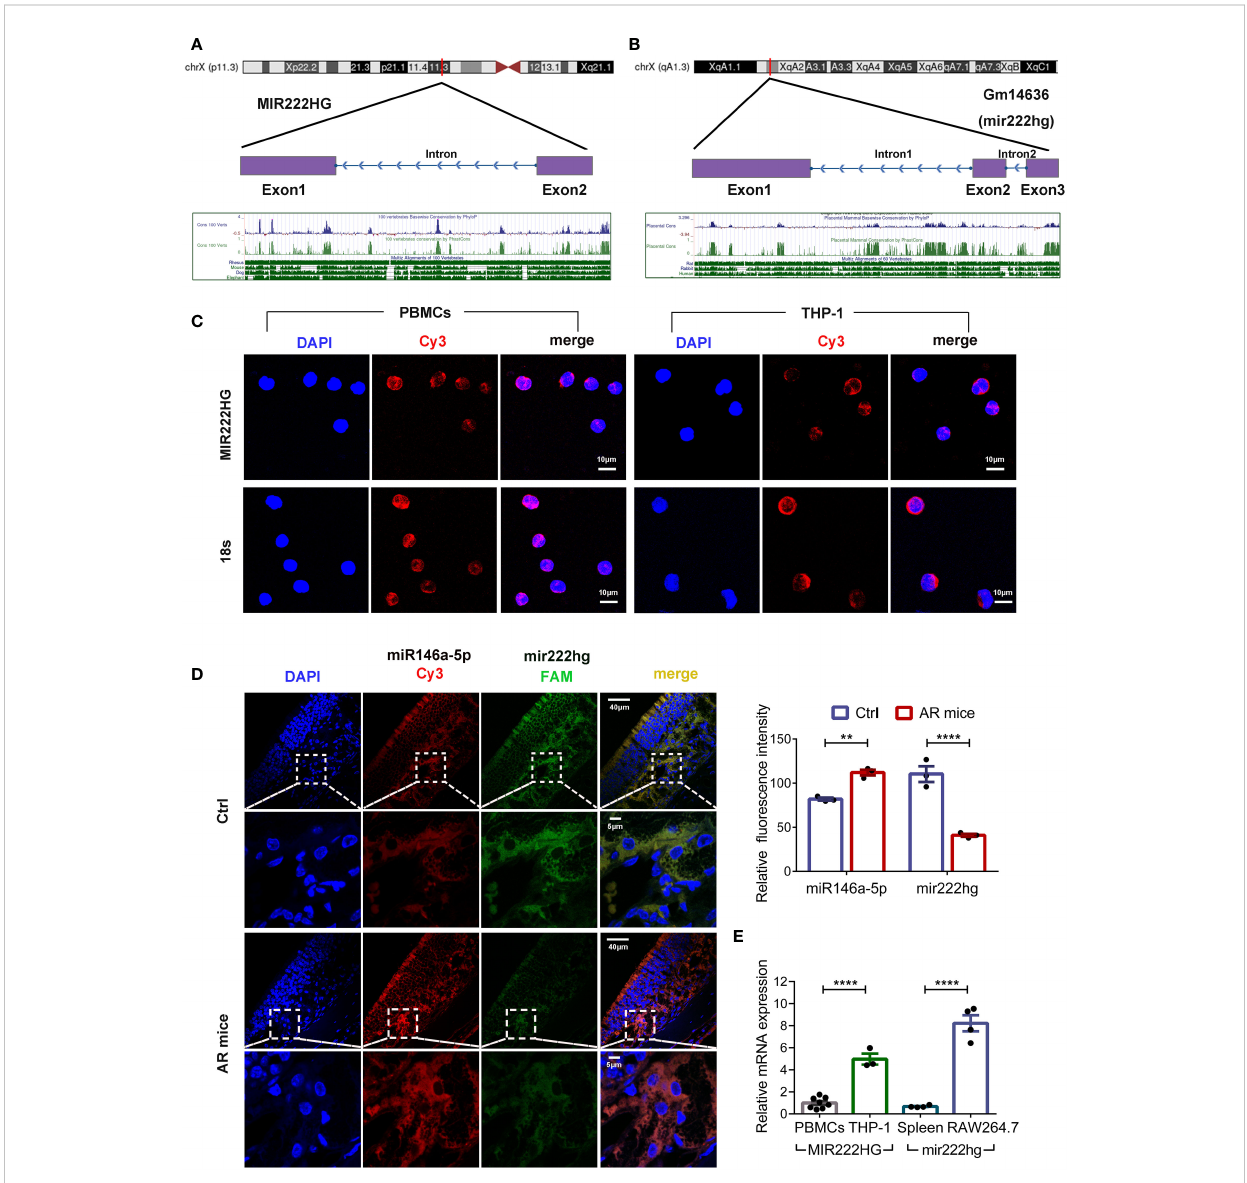
FIGURE 3 Conservation analysis and subcellular localization of MIR222HG/mir222hg (A) MIR222HG is mapped to the human chromosome X:45,745,211- 45,770,274 with a high degree of conservation in its sequence. (B) Gm14636(mir222hg) is located on murine chromosome X:19,023,220-19,033,471 with a high degree of conservation in sequence. (C) Representative images of RNA-Fluorescence in Situ Hybridization (RNA-FISH) assay showing subcellular localization of MIR222HG in PBMCs and THP-1 cells (MIR222HG-Cy3-red; nucleus-DAPI-blue). 18s was used as the positive control. Scale bars, 10 m m. (D) Representative images (left) and quanti fi cation analysis (right) of RNA-FISH assay showing subcellular localization and expression of mir222hg and miR146a-5p in nasal mucosa tissues (miR146a-5p-Cy3-red; mir222hg-FAM-green; nucleus-DAPI-blue). Scale bars, 5 m m and 40 m m. (E) The qRT-qPCR was used to detect the difference in relative transcript-level expression of MIR222HG/mir222hg between human PBMCs, THP-1 cells, mouse spleen cells, and RAW264.7 cells. Each point represents data from one individual sample. Data are shown as the mean ± SEMs (n= at least 3 samples per group). Data are merged from three independent experiments. (C, D) Images are representative of three independent experiments. Statistical signi fi cance was assessed by unpaired t-test for experiments comparing two groups, whereas two-way ANOVA followed by Sidak ’ s multiple comparisons test was used for comparisons between more than two groups. ** p< 0.01, **** p<